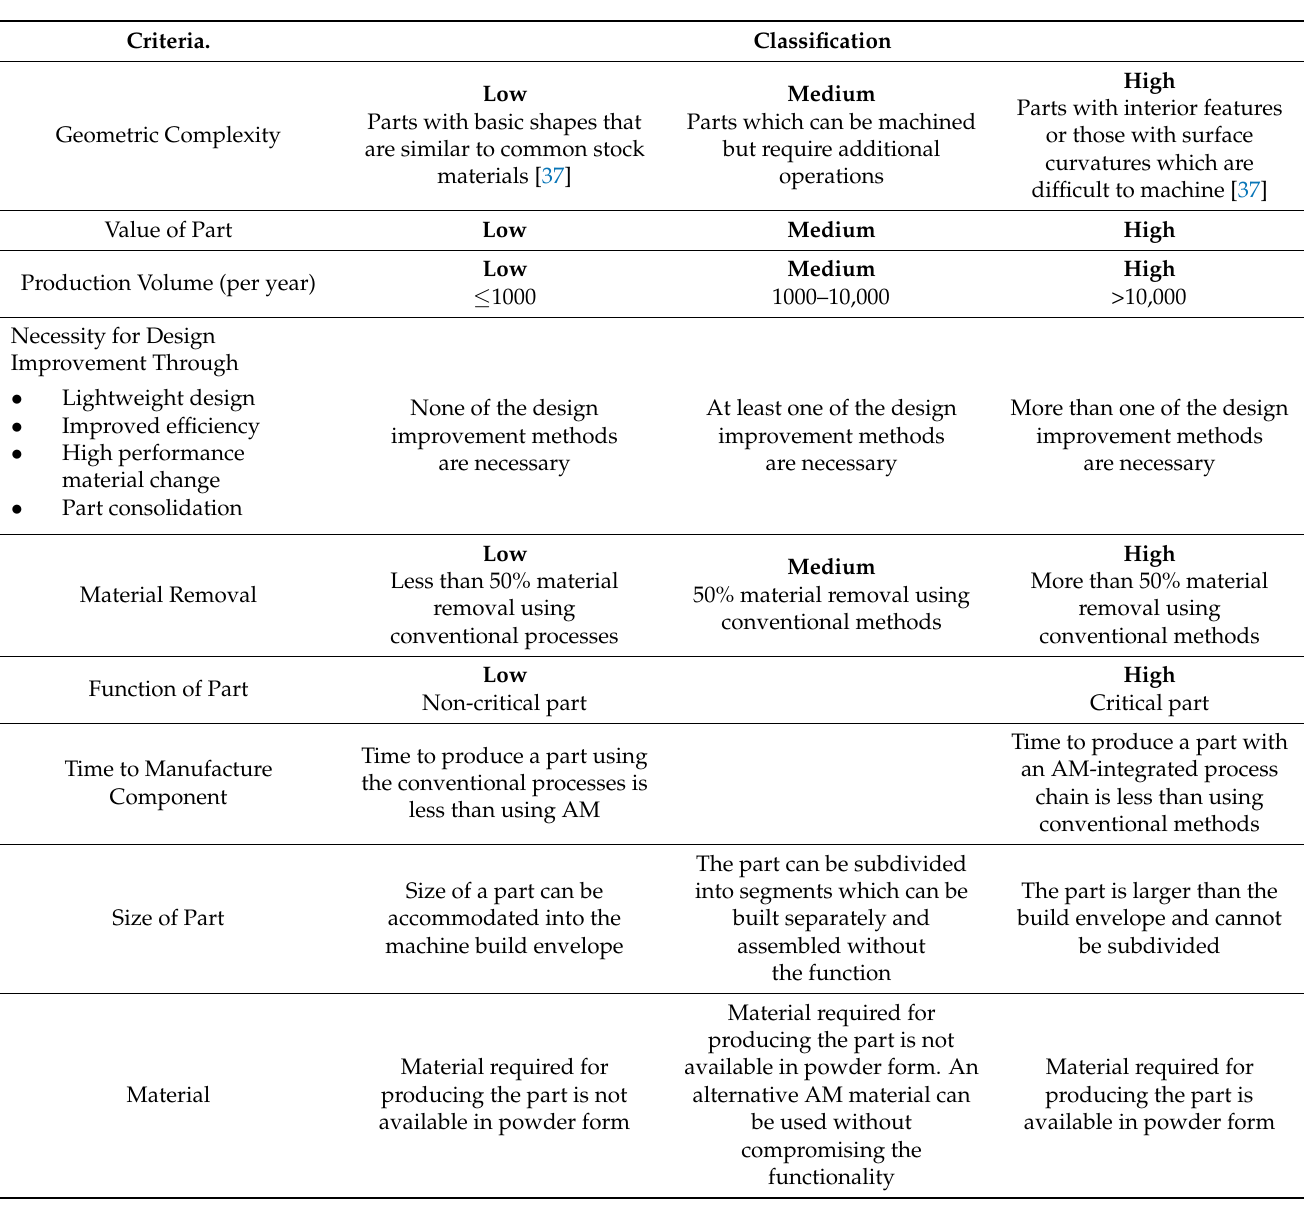
Table 3. Classification of